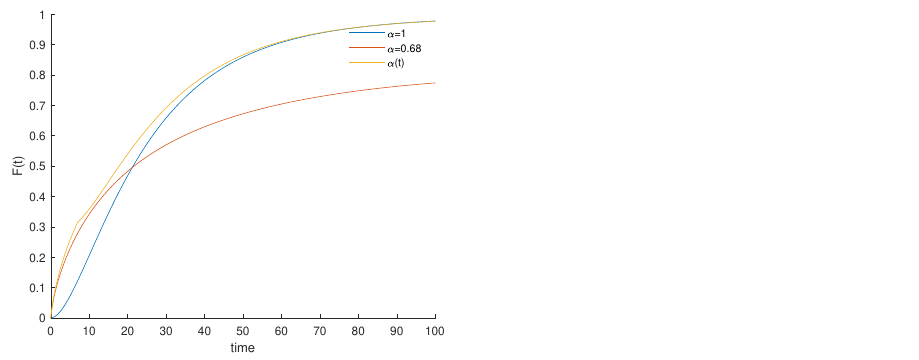
Figure 11. Evolution of the efficacy function for the FractInt system and for the FOCP with α = 1 and α = 0.68, considering the parameter values from Table